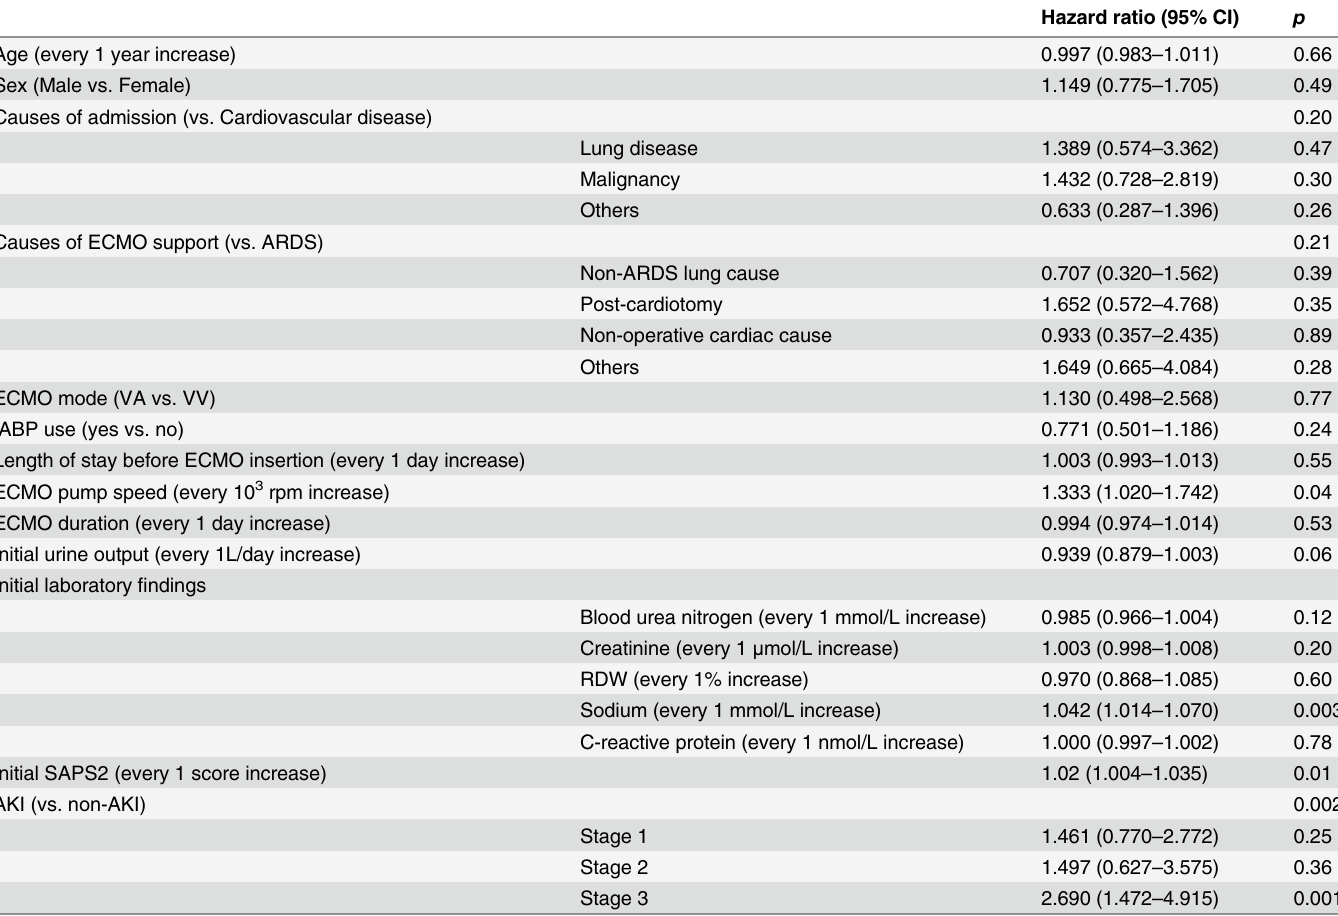
Table 2. Multivariate Cox-proportional hazard regression analysis for in-hospital